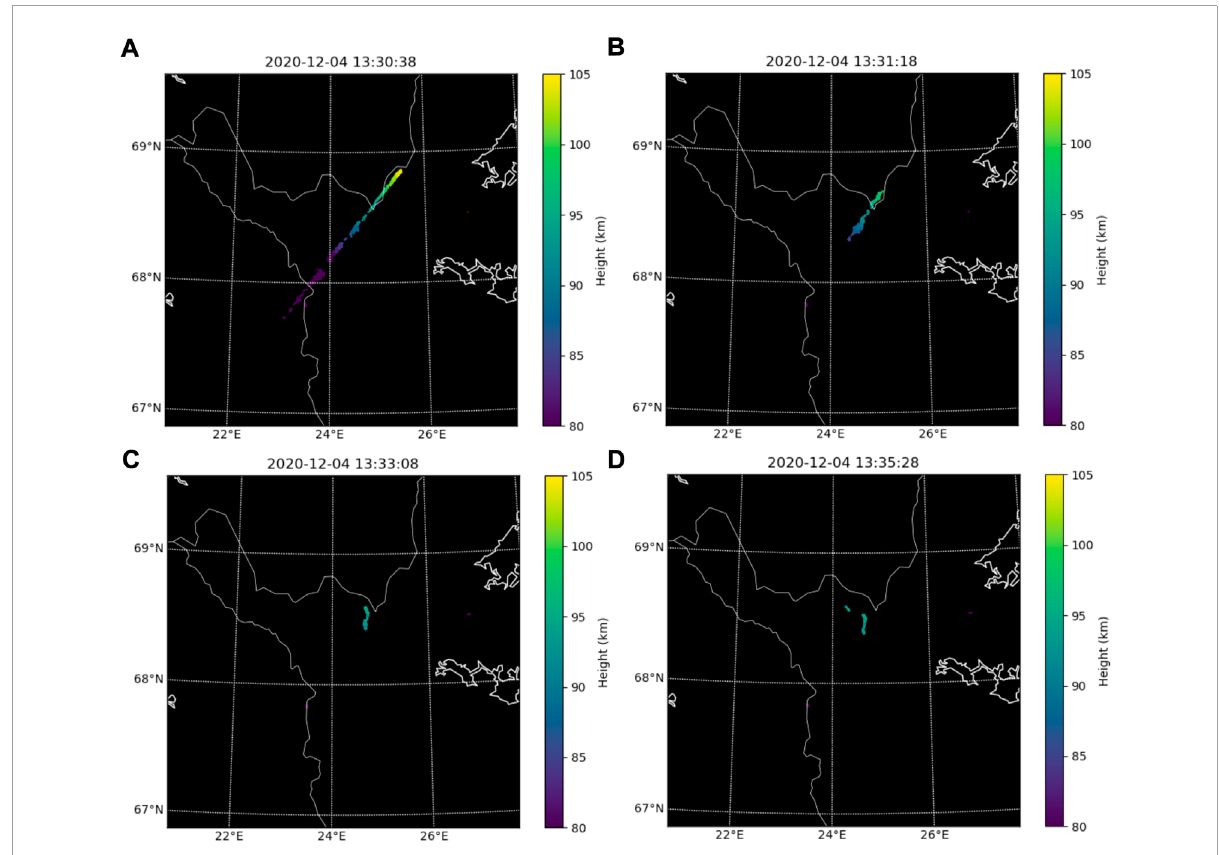
FIGURE 9 Trail echo range-Doppler bin positions as a function of time. The amount of time after trail formation in each plot is (A) 0 − 10 s, (B) 50 − 60 s, (C) 150 − 160 s, (D) 290 − 300 s. The trail can be seen contracting due to ambipolar diffusion and recombination. The longest duration echo is observed at approximately 92 km altitude. The action of the neutral wind in the mesosphere can also be seen in the position of the trail echo, as a wind shear rotates and twists the trail. An animated sequence of radar images is provided as a supplement to this